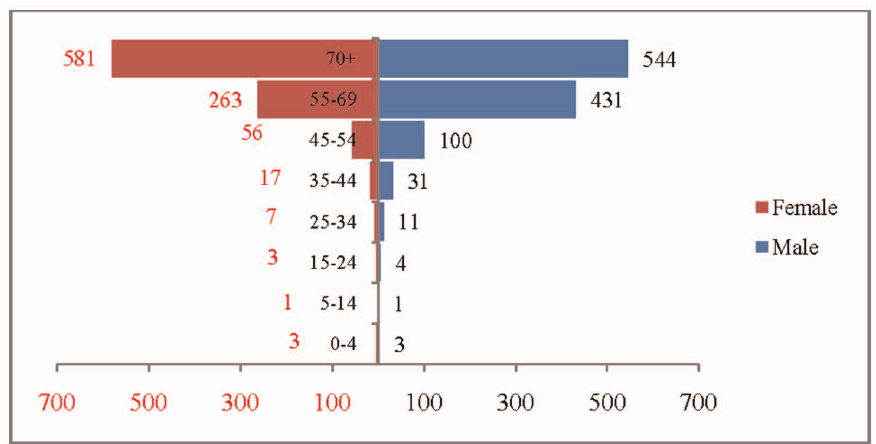
Figure 6. Sensitivity analyses for the estimates of CVD deaths in India, 2010–21.